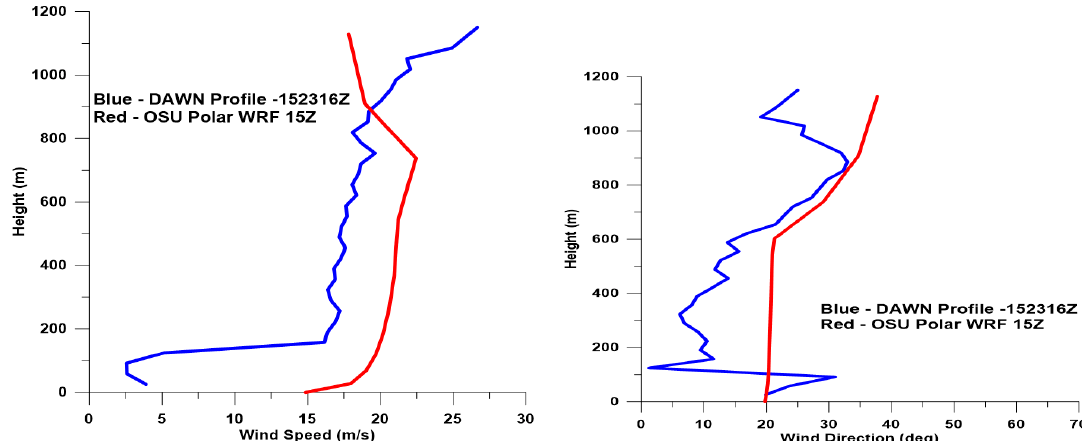
Figure 19. DAWN and model profiles of wind speed ( left ) and wind direction ( right ) near 1523Z on 31 October 2014 for the middle of leg 3 east of the tip.